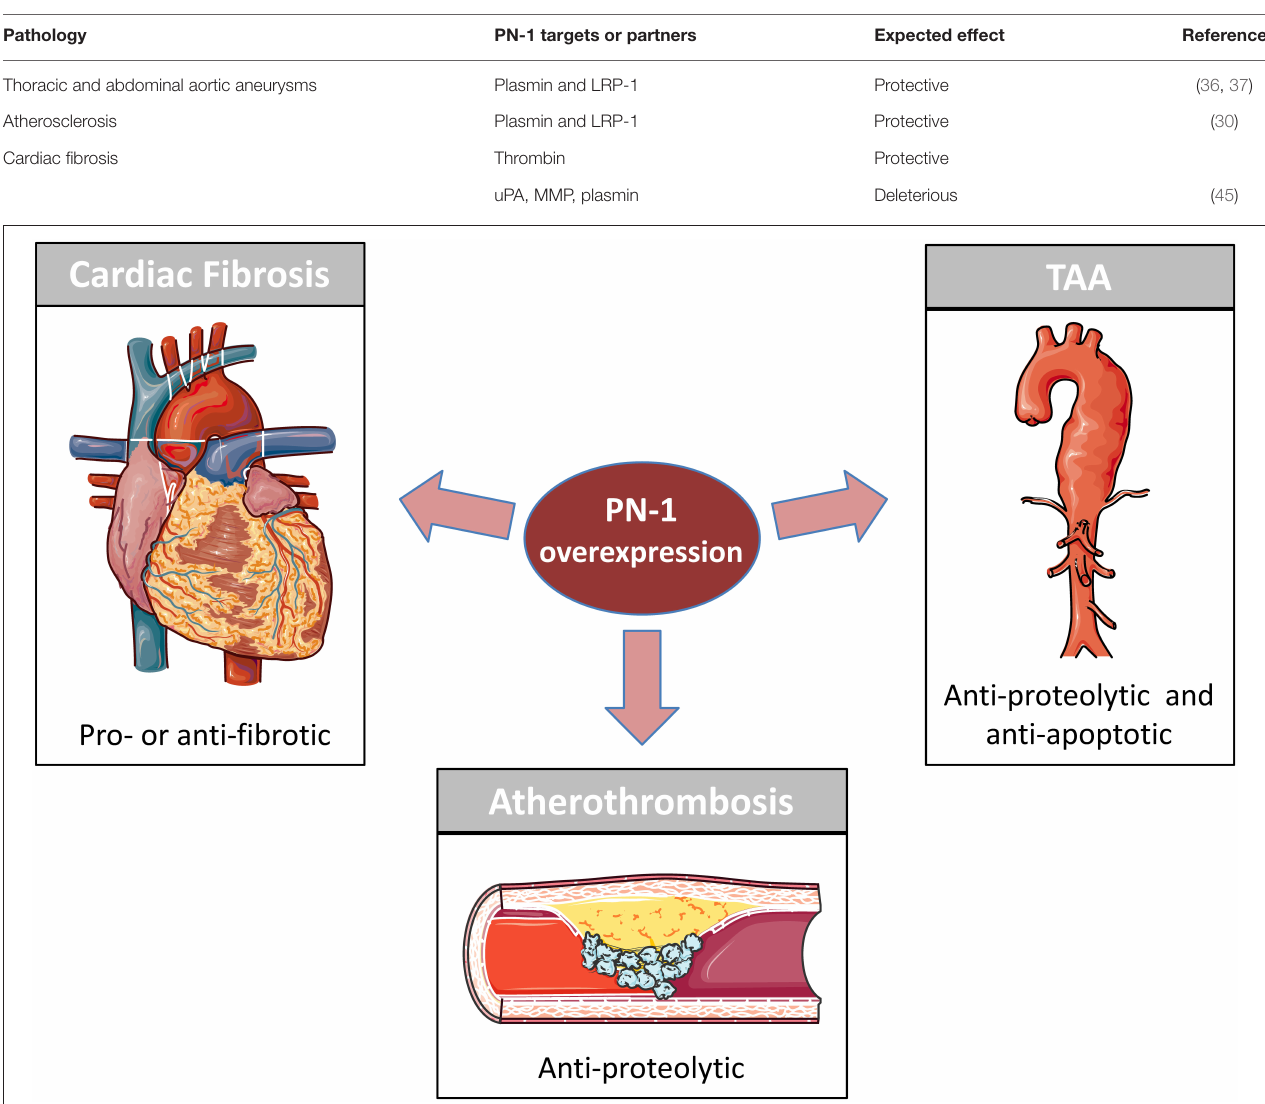
TABLE 1 | Expected effect of PN-1 in cardiovascular diseases depending on its targets or partners.